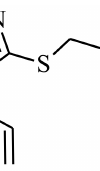
Figure 1. Chemical structure for the title compound ( Atr ).